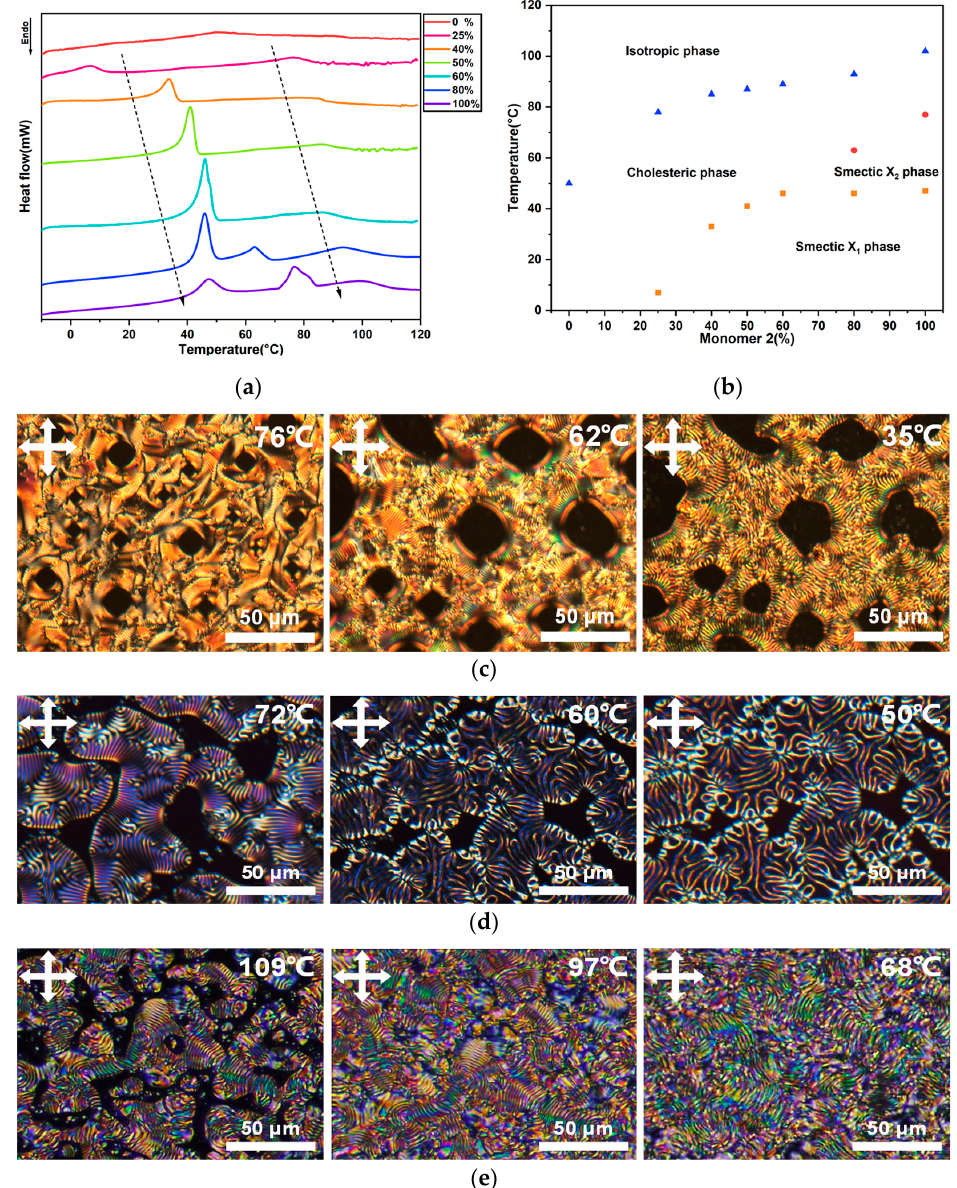
Figure 3. ( a ) DSC thermograms of the CLC oligomers during the cooling cycle at a cooling rate of 5 °C/min. ( b ) Phase diagram of CLC oligomers containing different concentrations of Monomer 2. ( c ) POM images of CLC oligomers with 40%, ( d ) 80%, and ( e ) 100% Monomer 2 at various temperatures under cooling.